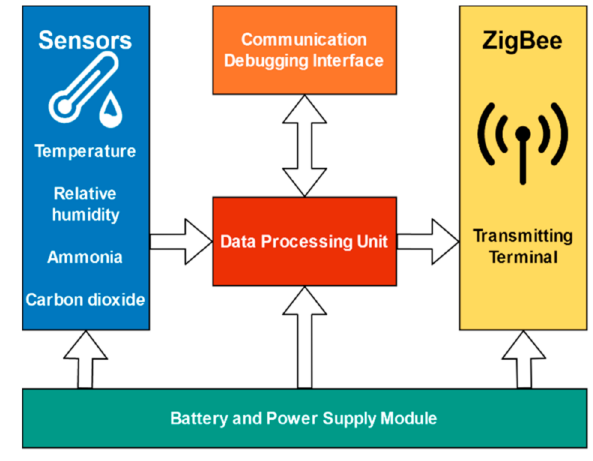
Figure 6. Slave node structure.